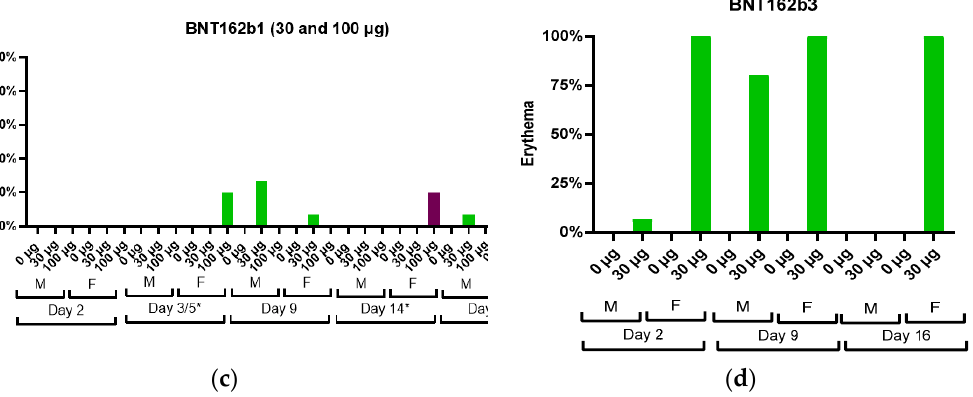
Figure 3. Erythema incidence and severity in male (M) and female (F) Wistar Han rats immunized intramuscularly (IM) with ( a ) BNT162b2 V8 (100 µg), ( b ) BNT162b2 V9 (30 µg), ( c ) BNT162b3 (30 µg), and ( d ) BNT162b1 (30 µg or 100 µg) or buffer control. Erythema measurements from Dosing Phase Days 2, 3/5 *, 9, 14 *, and 16. * Days 3/5 and 14 are only available for Study 1.